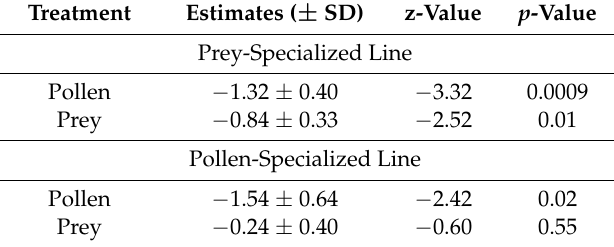
Table 2. The effect of two-spotted spider mites and pollen availability on the rate of cannibalism (intraspecific prey per 24 h) in prey- and pollen-specialized lines of mullein bugs (lines were tested